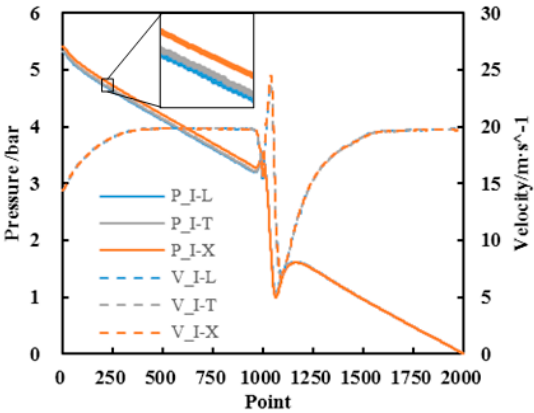
Figure 8. Pressure and velocity along passages I. Table 2. Pressure drop in the passage I.